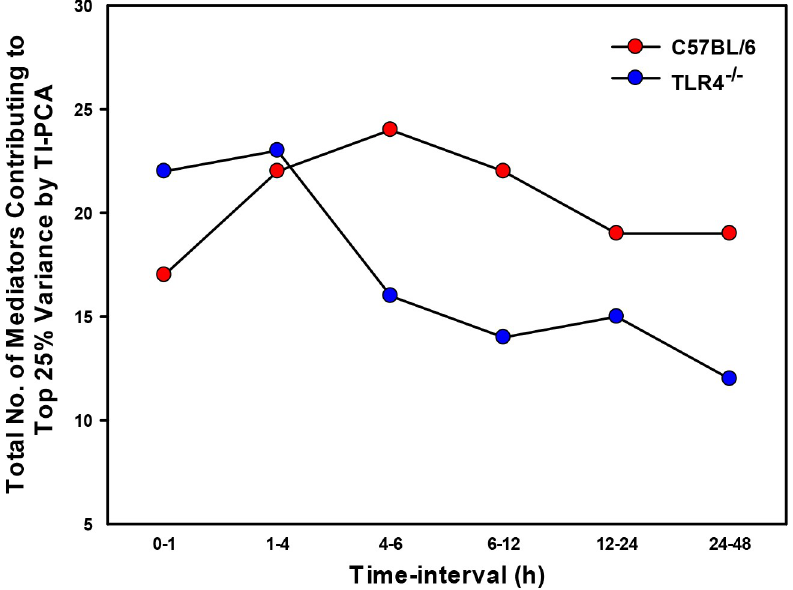
Fig 4. Total number of mediators contributing to the top 25% variance by Time-Interval PCA (TI-PCA) in C57BL/6 vs. TLR4 -/- mice. Animals (C57BL/6, n = 5–8 and TLR4 -/- , n = 4 for each experimental group) were injected with LPS (3 mg/kg, i.p.). At different time points upon sacrifice, the inflammatory mediators in blood and different organs (liver, heart, gut, lung, spleen and kidney) were measured by Luminex and Time-Interval PCA was performed as described in Materials and Methods . Figure shows the total number of mediators contributing to the top 25% variance of the inflammatory response in each organ as well as in plasma of C57BL/6 vs. TLR4 -/- mice during the indicated